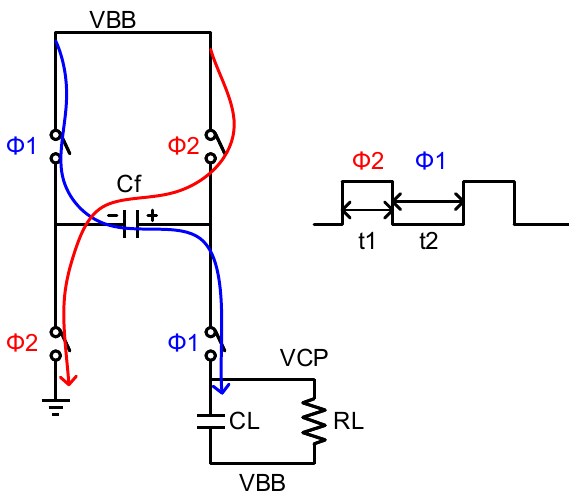
Figure 2. Block diagram of switched capacitor